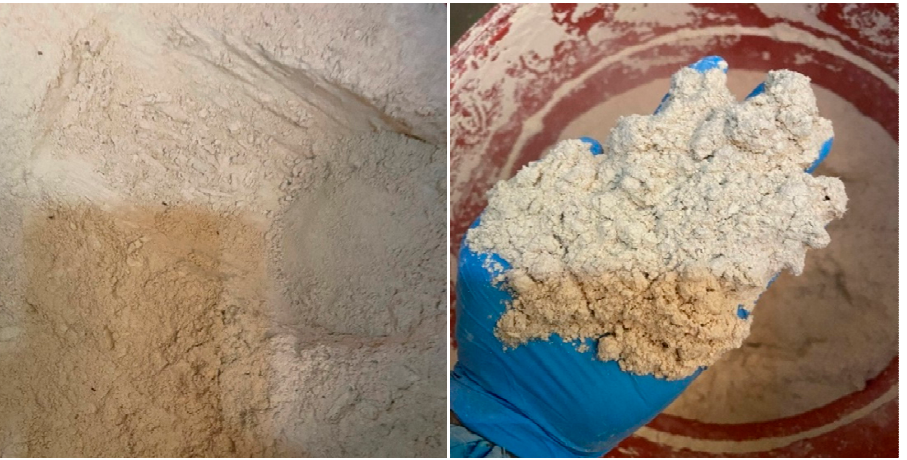
Figure 1. Poultry dust obtained from the exhaust fan of the cage-free laying hen house at the UGA research